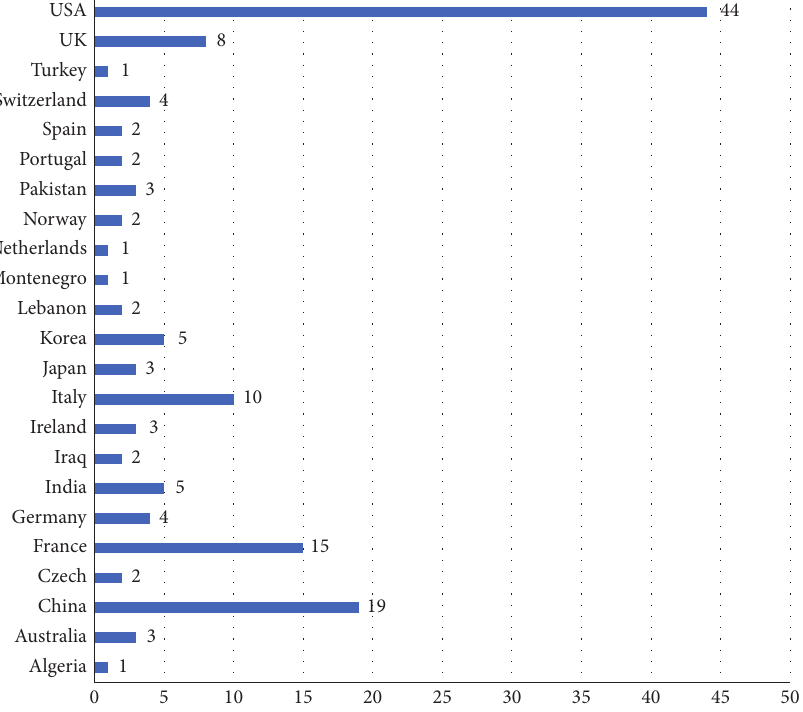
Figure 13: Distribution by authors’